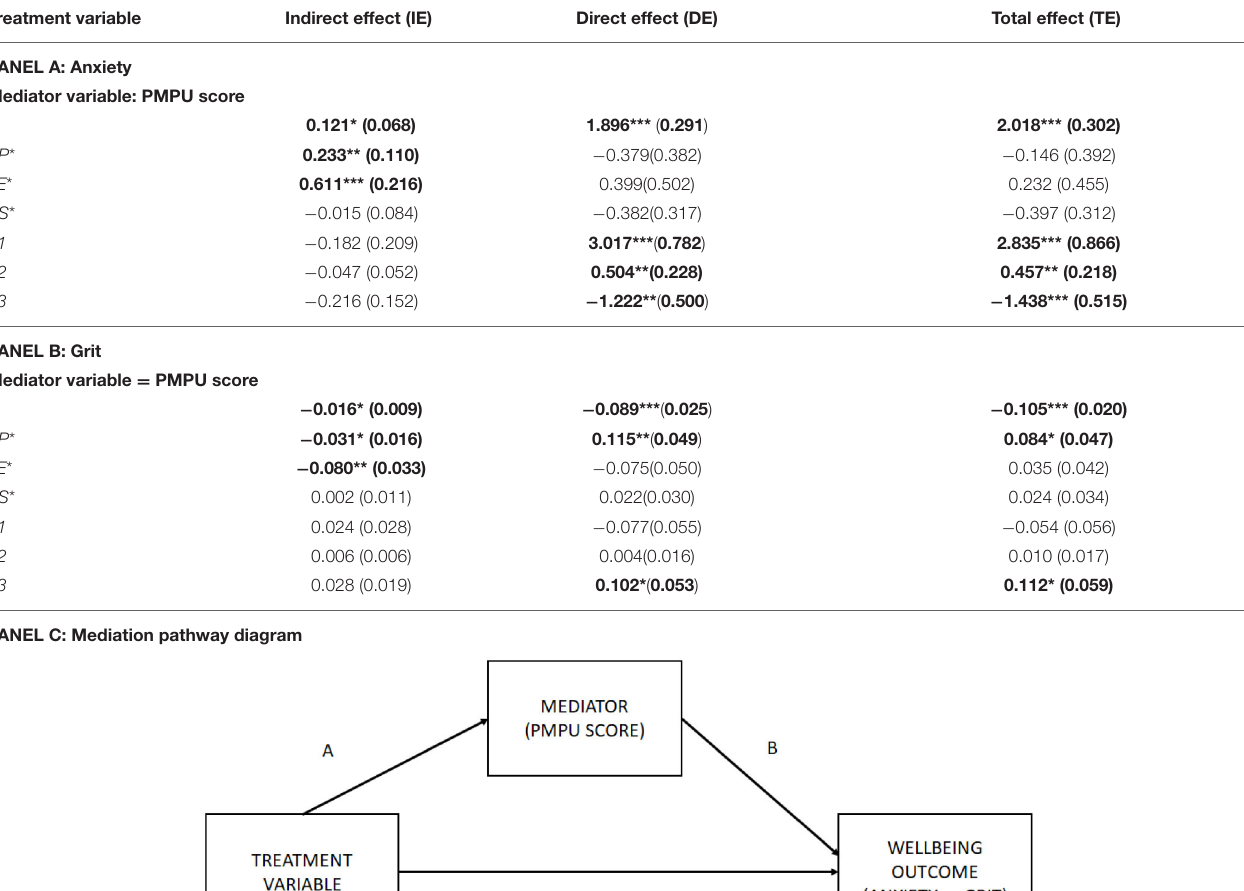
TABLE 5 | Mediation analysis for generalized linear estimation of structural model of adolescent life influences on well-being. Treatment